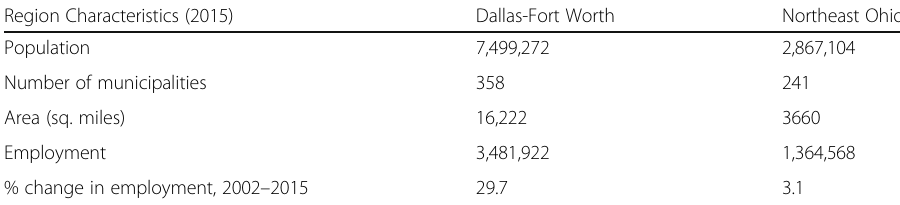
Table 1 Basic characteristics of the two study regions Region Characteristics (2015) Dallas-Fort